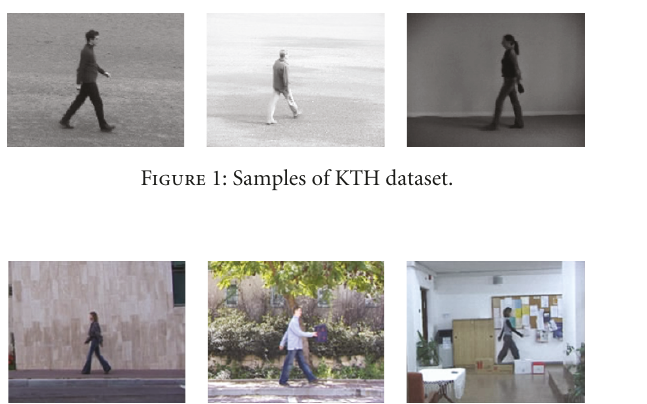
Figure 2: Samples of Weizmann dataset.